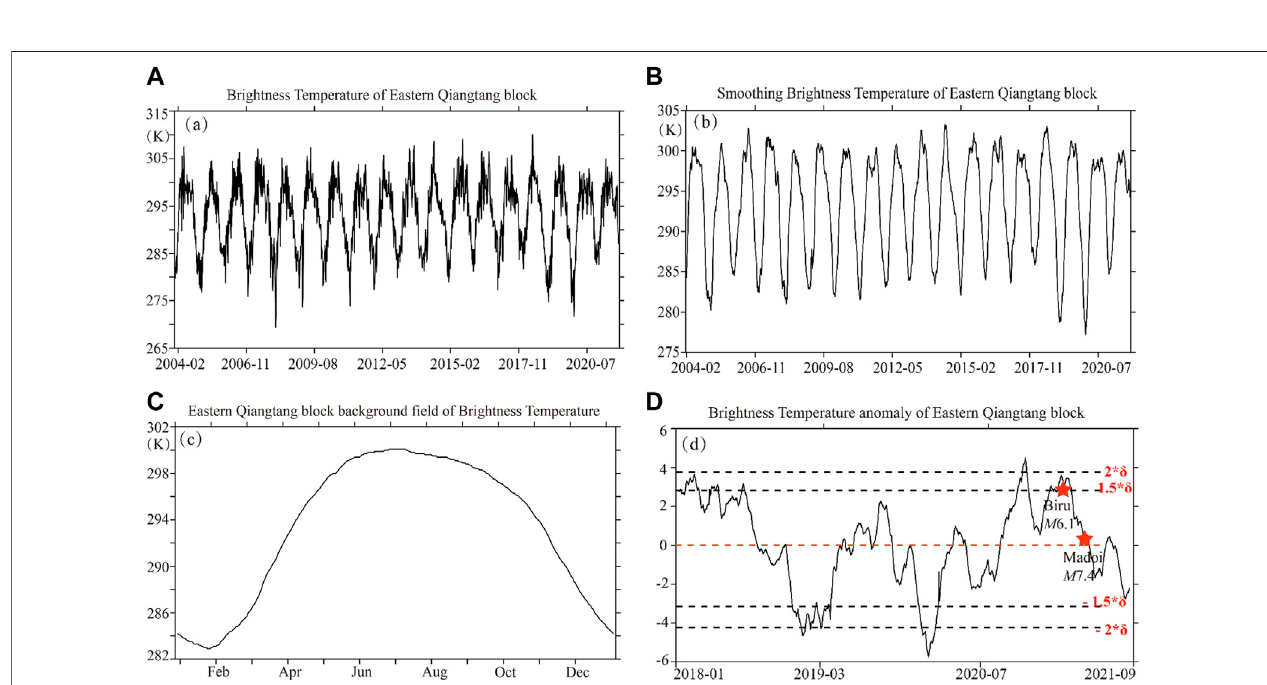
Frontiers in Earth Science |